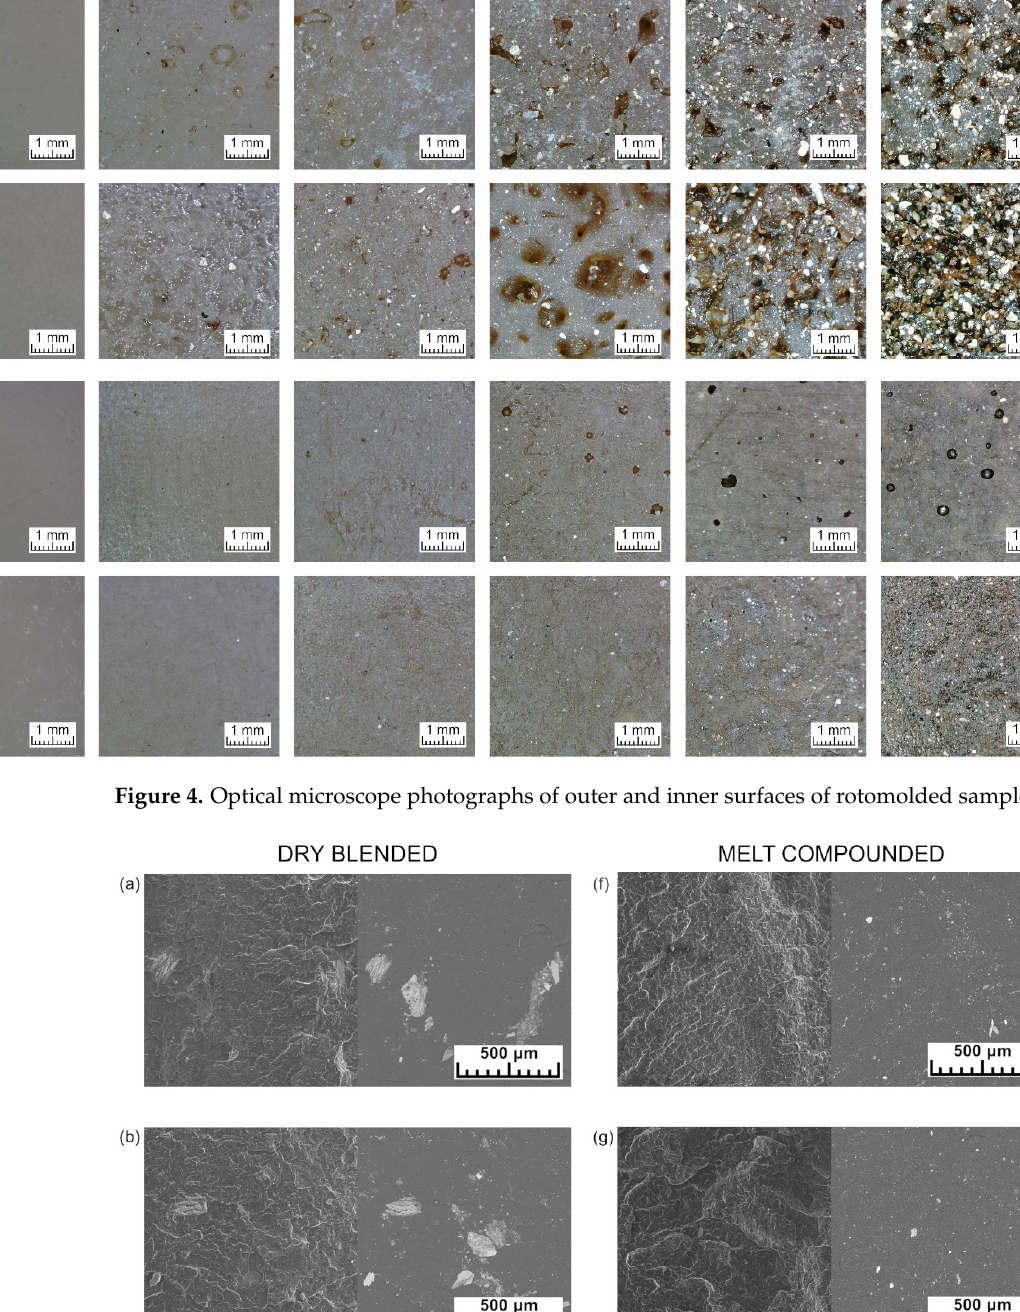
Figure 5. SEM images of cryo-fractured rotomolded samples: dry blended with 0.5 ( a ), 1 ( b ), 2 ( c ), 5 ( d ), and 10 wt% ( e ) of EV and melt compounded with 0.5 ( f ), 1 ( g ), 2 ( h ), 5 ( i ), and 10 wt% ( j ) of EV in the SE and BSE modes.